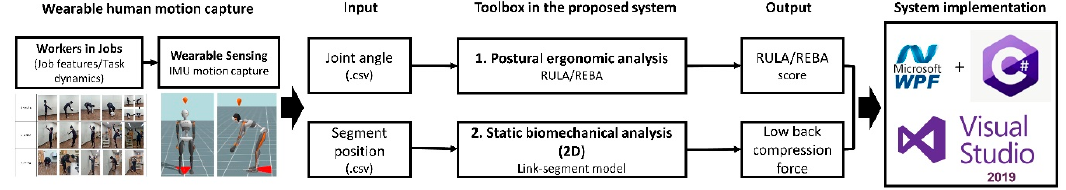
Figure 1. Conceptual design for the proposed system.